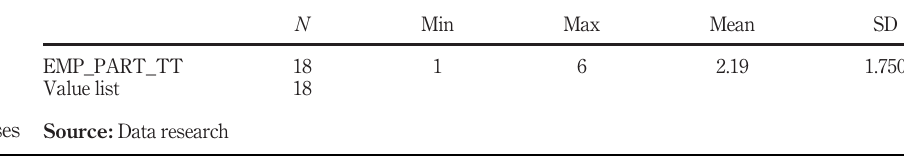
Table 1. Descriptive analyses